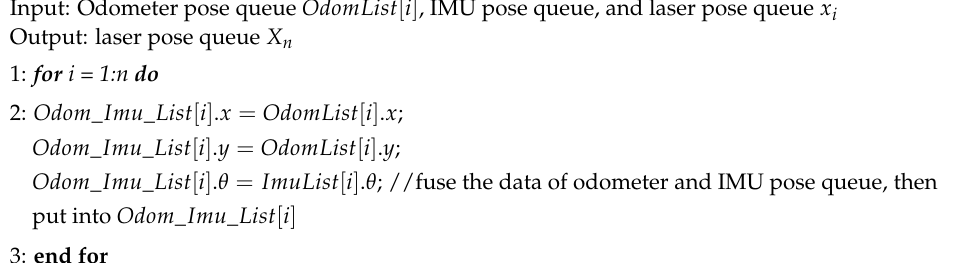
Algorithm 1: A Pose Estimation Algorithm Based on IMU and